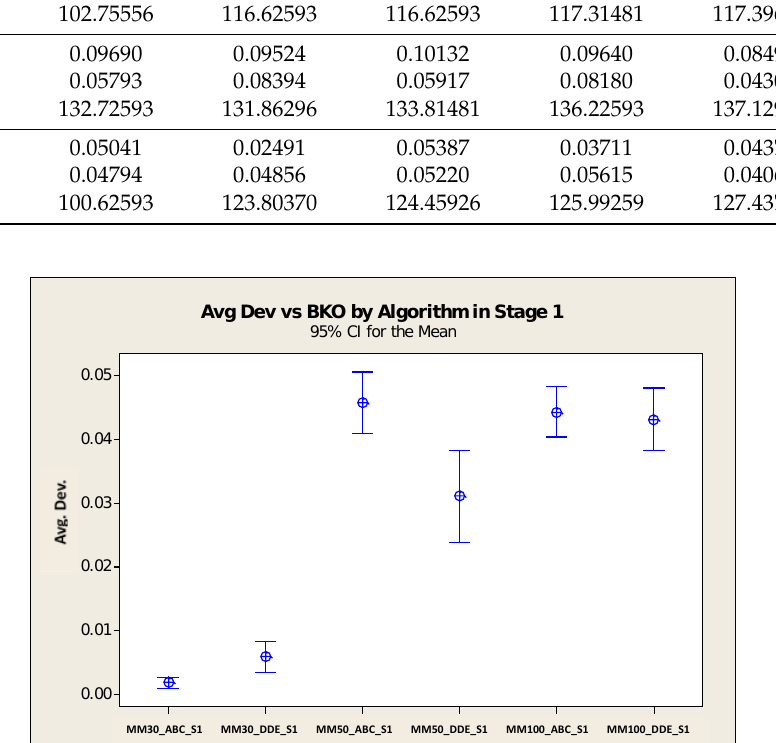
Figure 3. Avg dev vs. BKO CI for each algorithm in Stage 1 (MRCPSP/max).